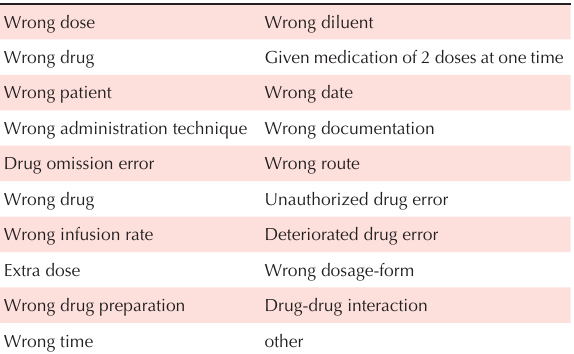
Table 1. Types of medication errors Wrong dose Wrong